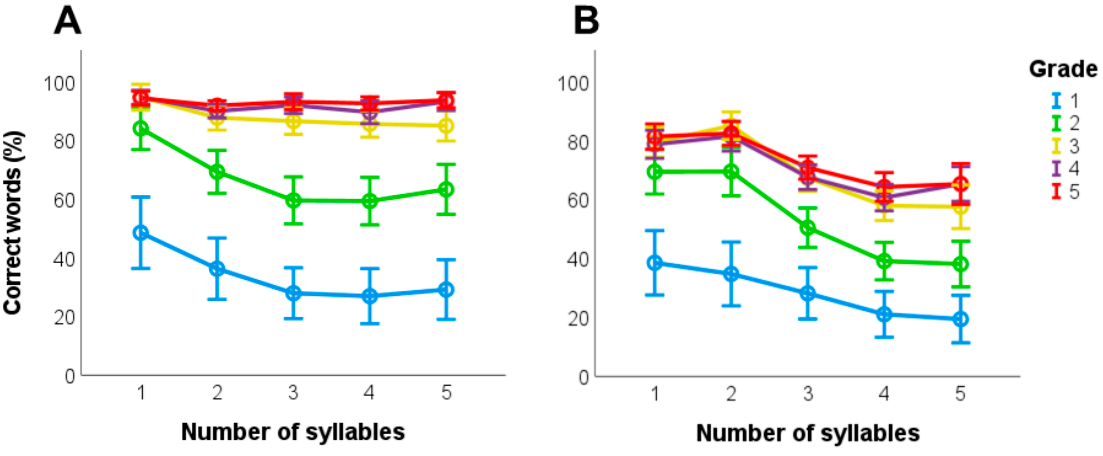
Figure 1. Percentage accuracy according to grade and number of syllables of words ( A ) and nonwords ( B ). Error bars represent 95% confidence interval. Table 2. Descriptive values of percentage accuracy according to grade and stimuli type and length.